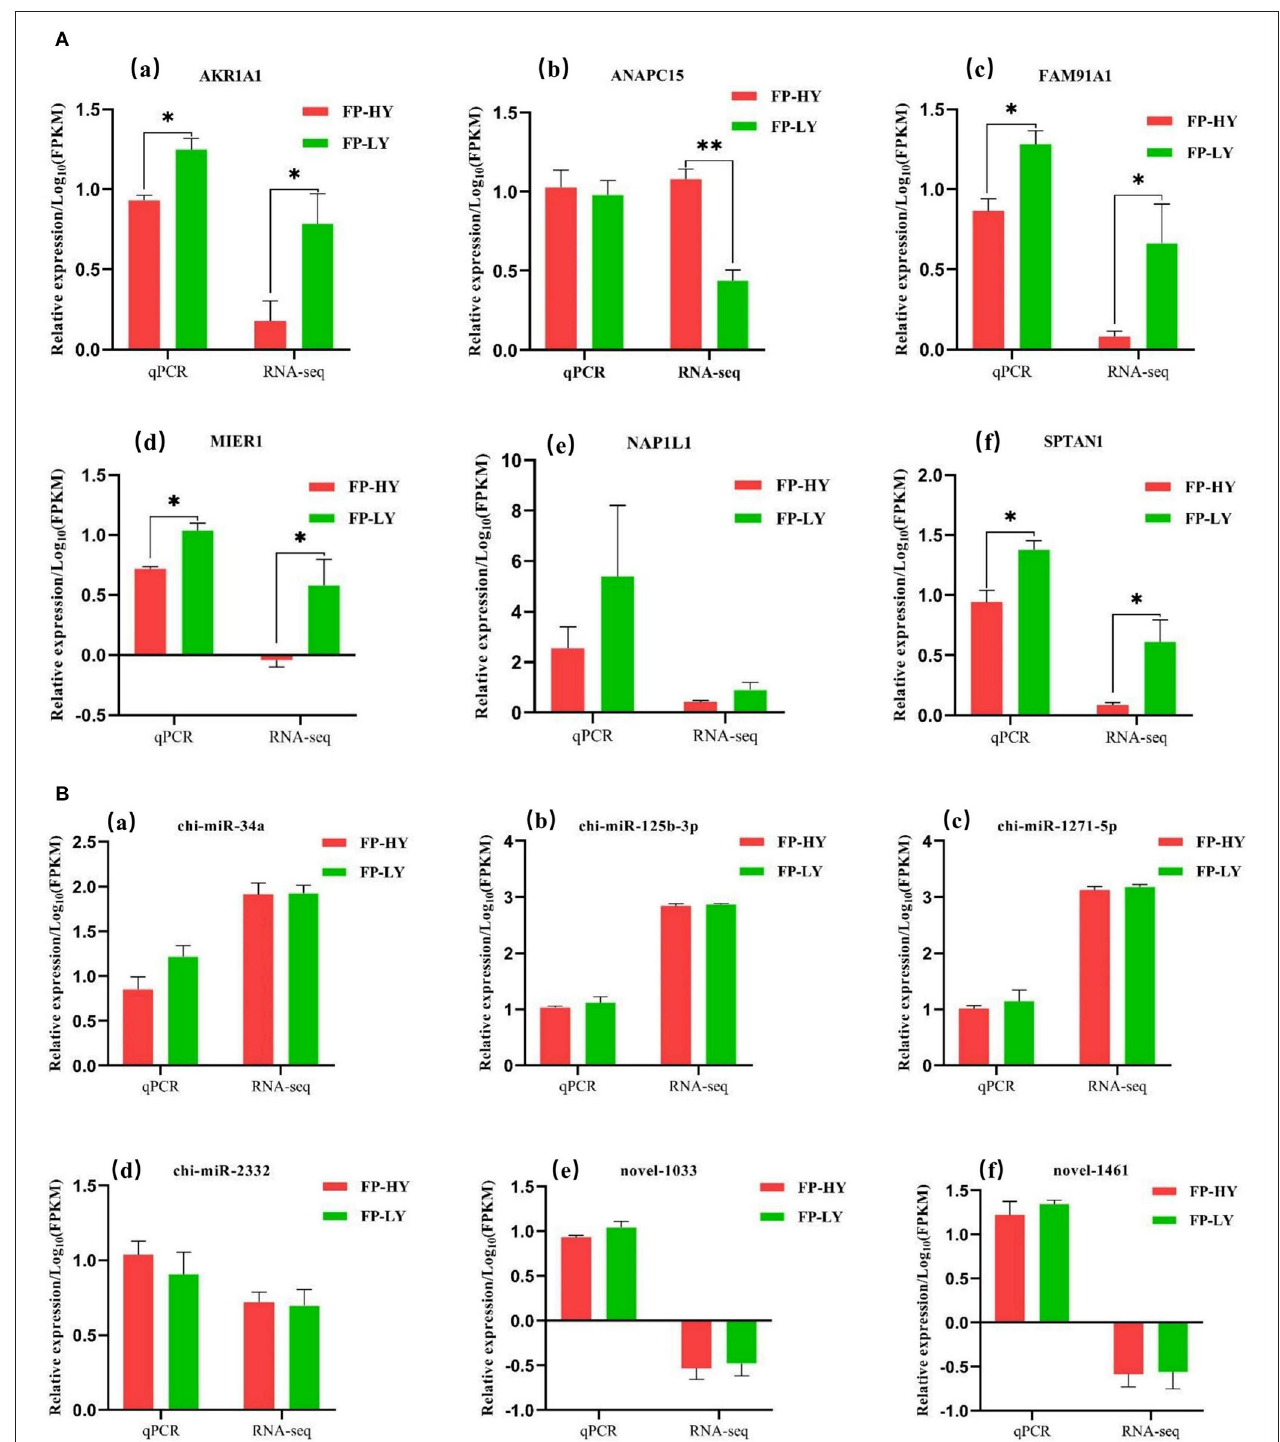
FIGURE 7 | qPCR validation of mRNAs (A) and miRNAs (B) identified by RNA-seq in FP-HY and FP-LY. ** p < 0.01, * p < 0.05.